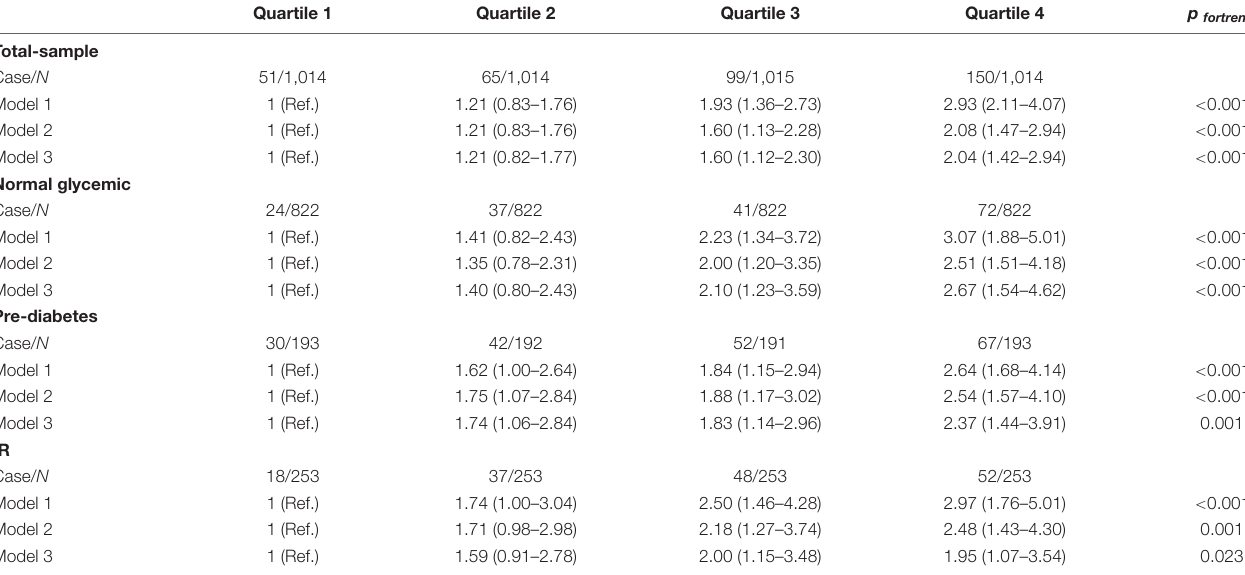
TABLE 2 | HRs and 95% CI for the association between the quartiles of the indicator and incidence of T2DM in the total, normal glycemic, prediabetes, and IR samples. Quartile